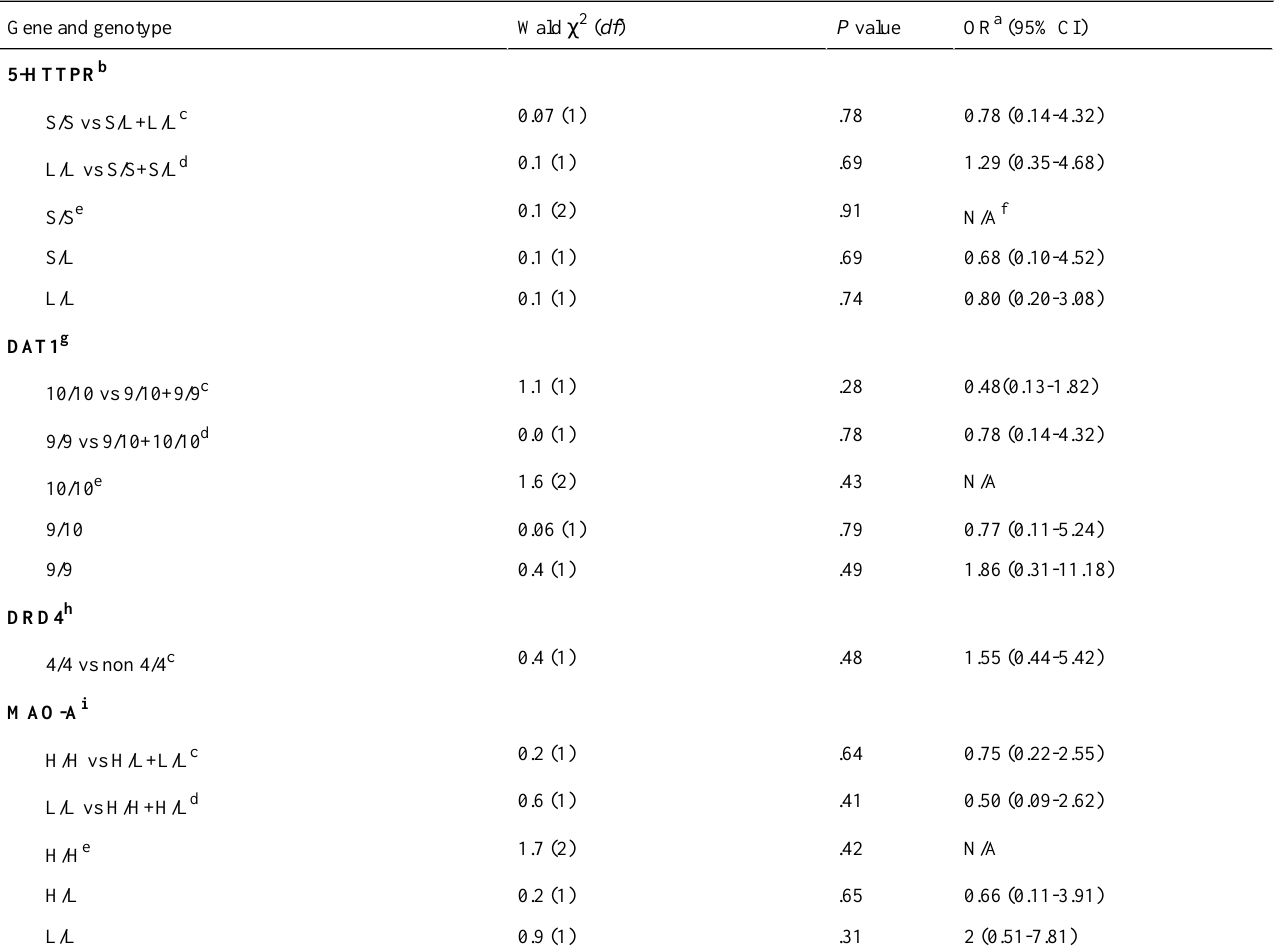
Table 4. Association between internet addiction and genetic polymorphisms in serotonin-transporter, dopamine active transporter 1, dopamine D4 receptor, and monoamine oxidase A among female